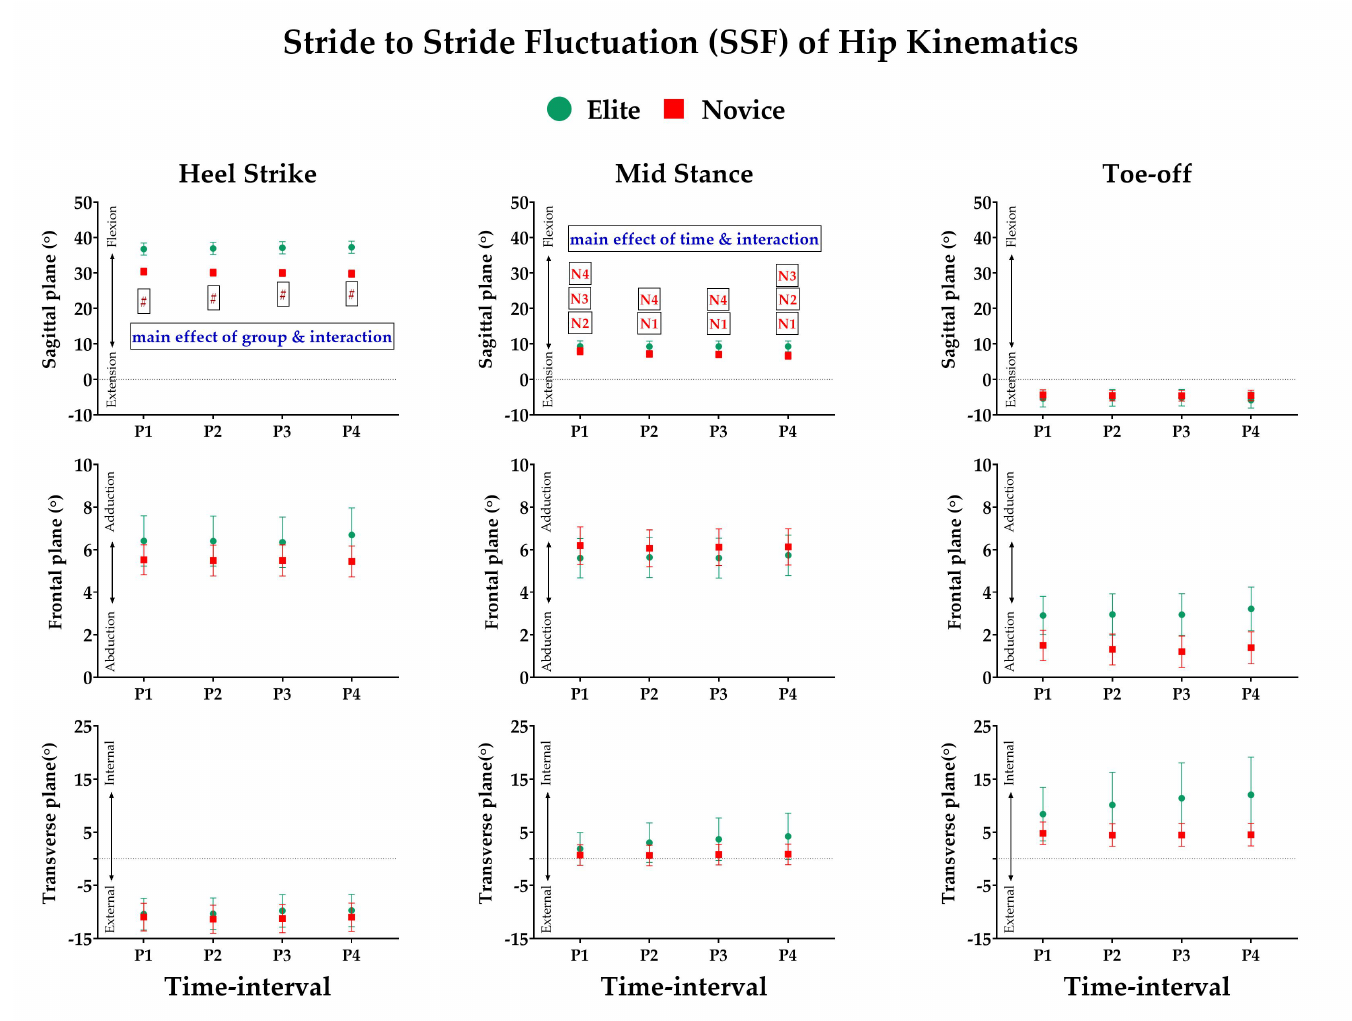
Figure A4. The results of the kinematics of hip joint SSF angle between elites (circle) and novices (square) in each phase of the prolonged run. The computed variable of SSF is represented on the Y -axis. The time-interval calculated by increasing the window size every five minutes is represented on the X -axis (P1: 0 to 5 min; P2: 0 to 10 min; P3: 0 to 15 min; and P4: 0 to 20 min). The figure depicts a significant main effect of group, time interval, and interaction. The outcome of a pairwise comparison for the time-interval difference is represented by letters (N for novice with the corresponding time- interval with a significant difference (e.g., N1 for the novices at time interval 0–5 min). Significant differences in a group for a specific time interval are marked with a “#”. (Note: only results with significant interaction have been